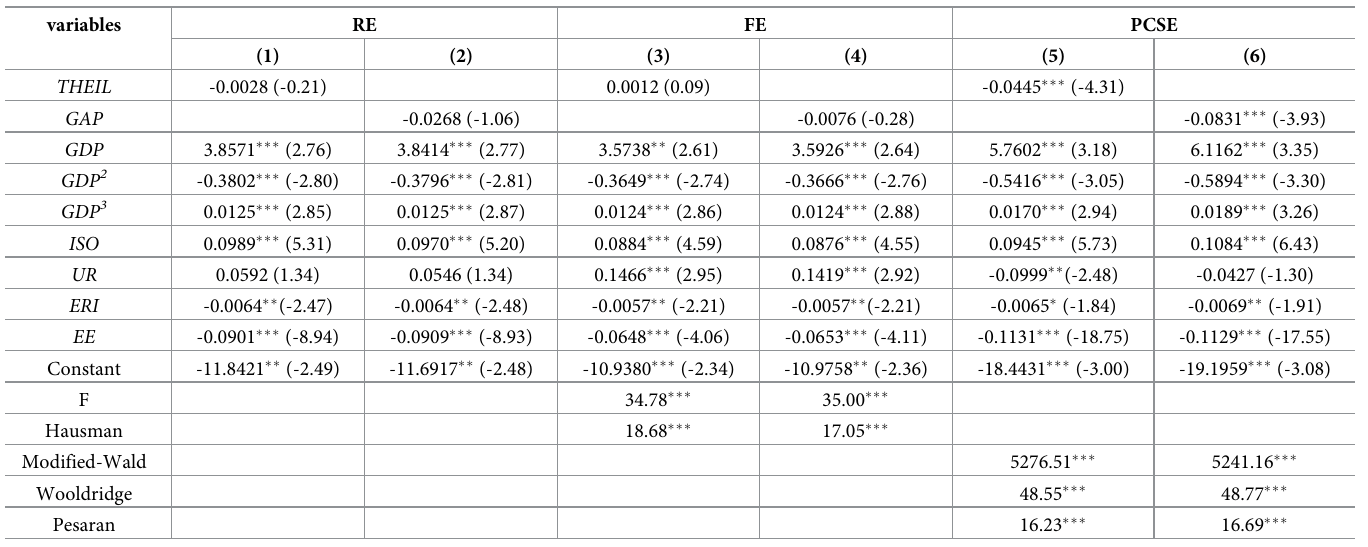
Table 4. Regressions of the urban-rural income gap on pollution